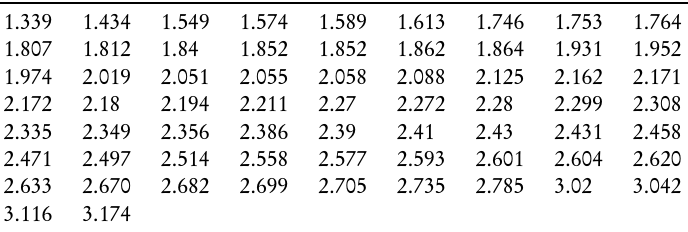
Data of failure stresses of single carbon